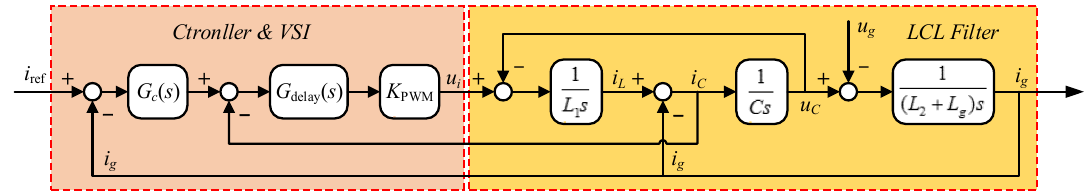
Figure 2. Current control block diagram of the LCL-filtered grid-connected inverter.